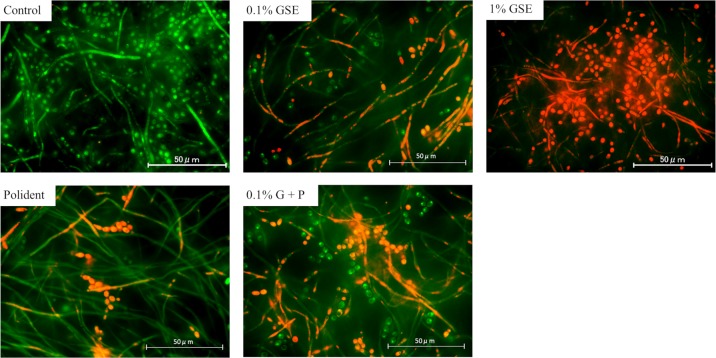
Biofilm on denture-base resin disc surface viewed using fluorescence microscopy to obtain a representative sample from each group.Green fluorescence showed living cells, and red fluorescence showed dead cells. The vast majority of fungus in the control groups appeared green; whereas, 1% GSE induced high mortality in the two morphogenetic forms, yeast and hyphae (increased red color). In the 0.1% GSE groups, dead cells were mainly observed in hyphal forms. The Polident groups showed cell death in yeast forms, but the vast majority of hyphal forms were alive (green). The 0.1% G+P groups showed many dead cells of the yeast and hyphal form.